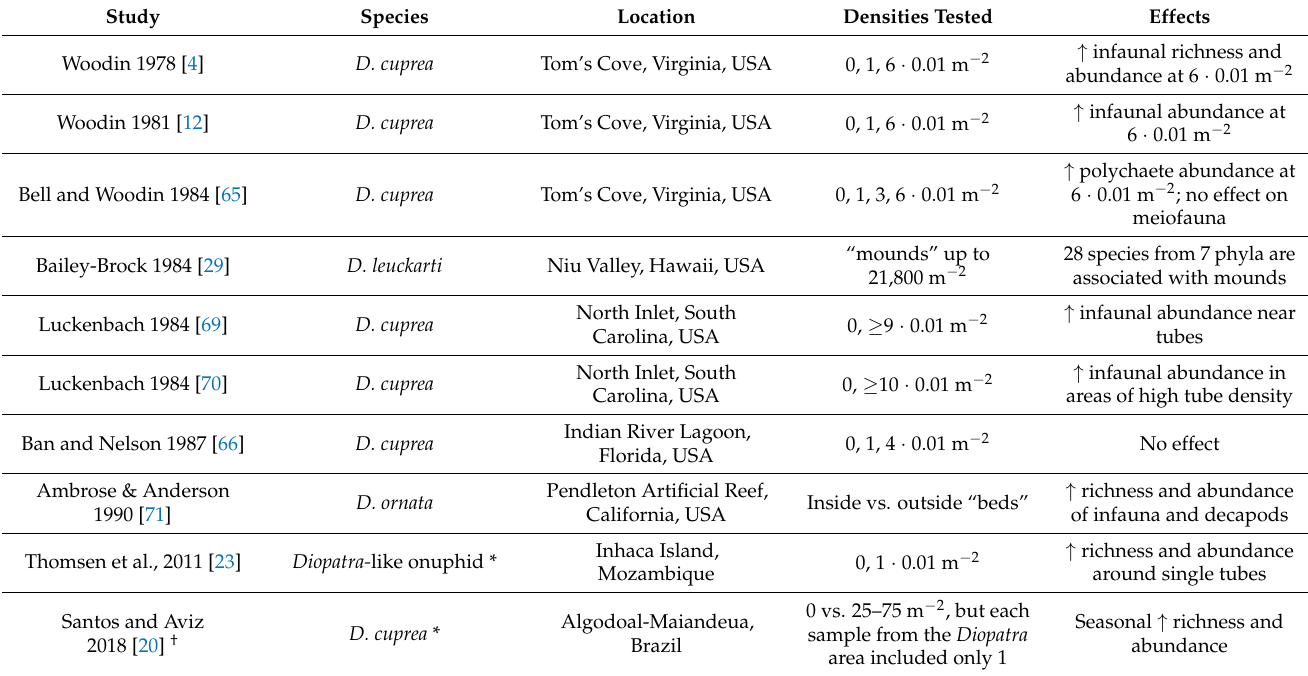
Table 2. Studies quantifying Diopatra facilitation of